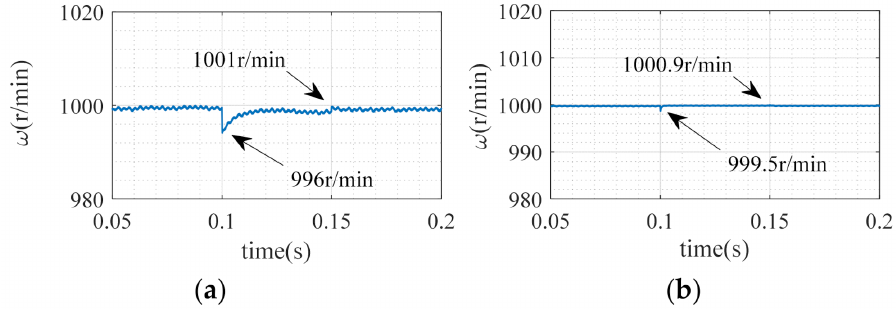
Figure 4. Speed response when the load torque changes: ( a ) SMC system with the FPRL; ( b ) SMC system with the